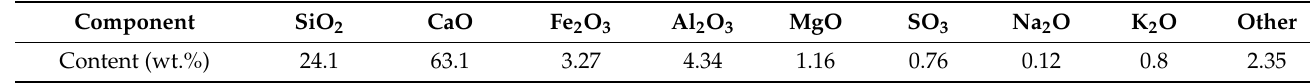
Table 2. Chemical compositions of used Portland cement.